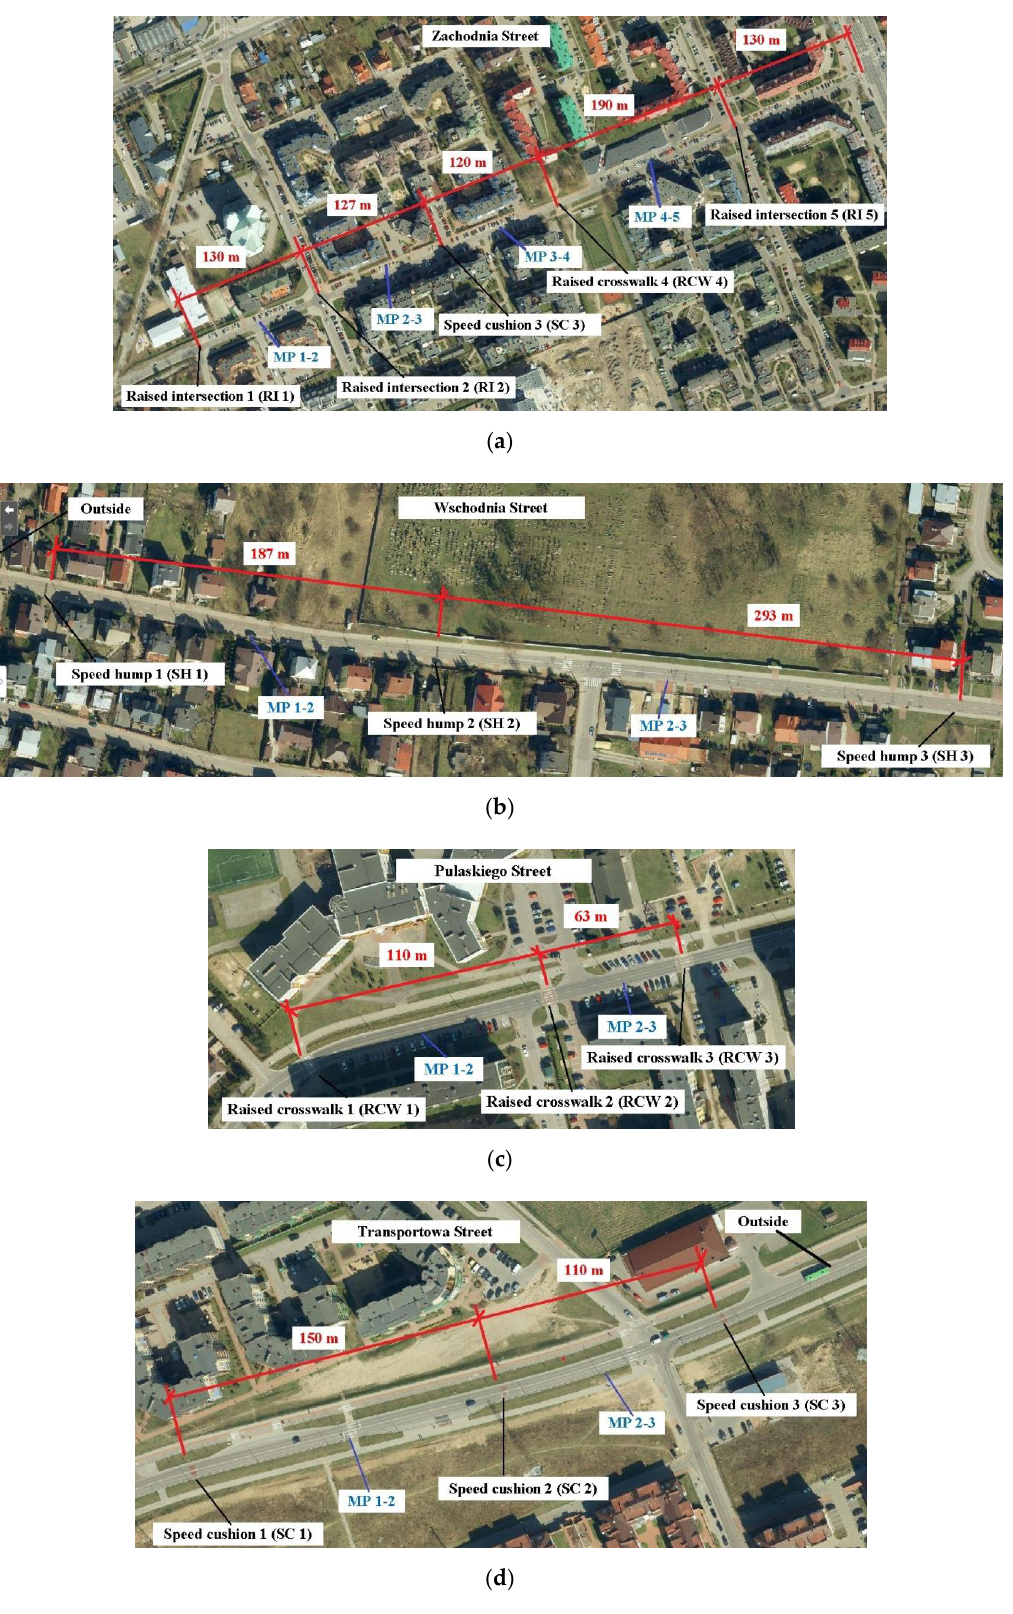
Figure 2. Schemes of traffic calming measures and measuring point in selected streets in Bialystok (Poland): ( a ) Zachodnia Street; ( b ) Wschodnia Street; ( c ) Pulaskiego Street; ( d ) Transportowa Street.